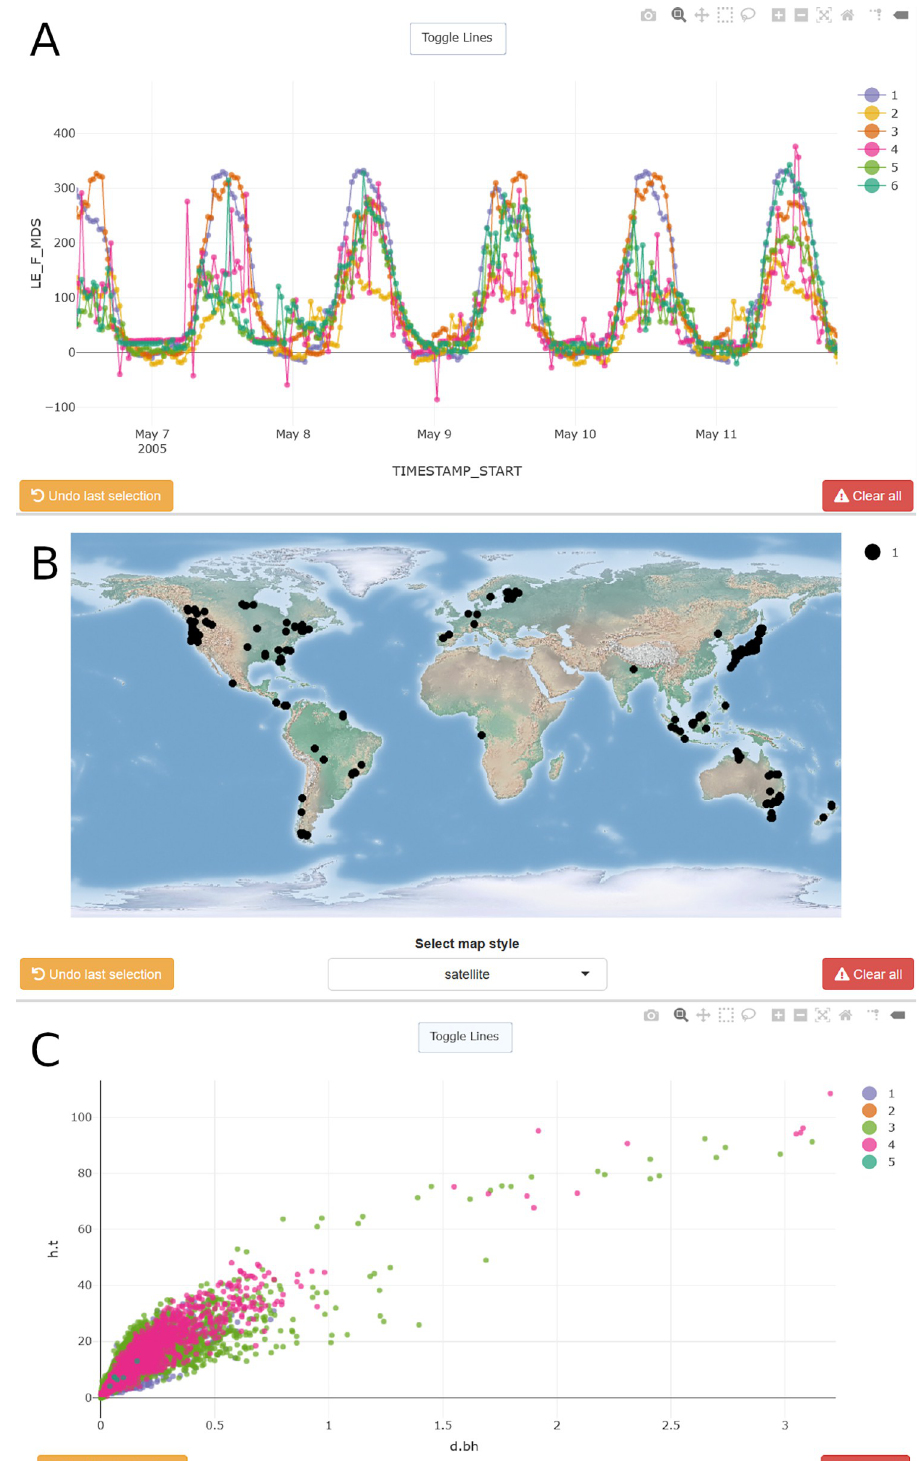
Fig 3. Examples of interactive visualizations. Panels show a subset of hourly time series of latent heat fluxes (A) from all Swiss FLUXNET2015 sites [4], spatial data illustrating sample locations for BAAD (B) and the relationship between stem diameter and height (C) with plant traits from BAAD [31]. Colors represent the grouping structure defined in the “Set-up” operation (A: Swiss sites; B, C: functional types).